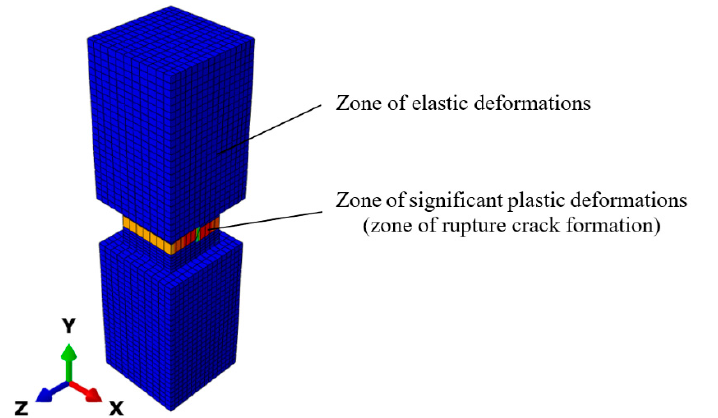
Figure 9. Deformation of a concrete specimen under uniaxial tension based on numerical modeling. Based on the test results the diagrams were performed in the axes “axial stress” and “tensile rupture crack opening.” These diagrams are shown in Figure 10. They are used as a basis for obtaining the diagrams shown in Figure